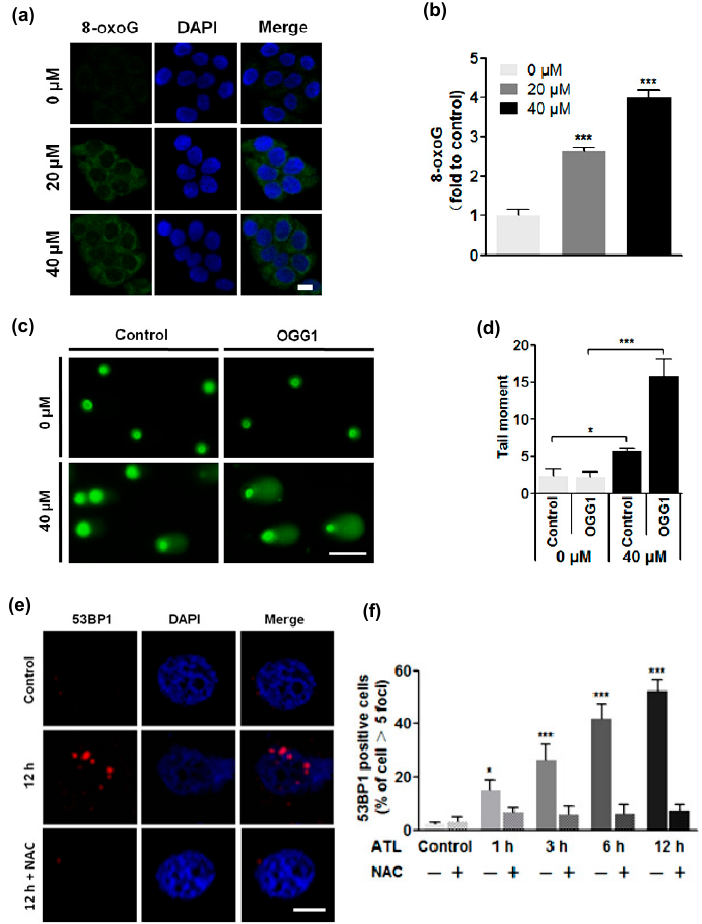
Figure 3. ROS overload resulted in extensive DNA damage. ( a , b ) Measurement of cellular 8-oxoG by Alexa 488-conjugated avidin: the level of cellular 8-oxoG was significantly increased in the colorectal cancer cells treated by 20 and 40 μ M ATL for 24 h (scale bar = 20 μ m) (*** p < 0.001 vs. vehicle control); ( c , d ) Comet assay: 24 h treatment with 40 μ M ATL significantly increased the number of cells with comet tails and the size of the tails, and pre-incubation with OGG1 further promoted the increase (scale bar = 100 μ m) (* p < 0.05, *** p < 0.001 vs. vehicle control); ( e , f ) Immunostaining of nuclear 53BP1: treatment with 20 μ M ATL for 1 h prominently increased the number of 53BP1 + cells, and longer treatments resulted in more 53BP1 + cells; however, inclusion of 5 mM NAC in the treatment completely blocked the 53BP1 signal (scale bar = 5 μ m) (* p < 0.05, *** p < 0.001 vs. vehicle control).